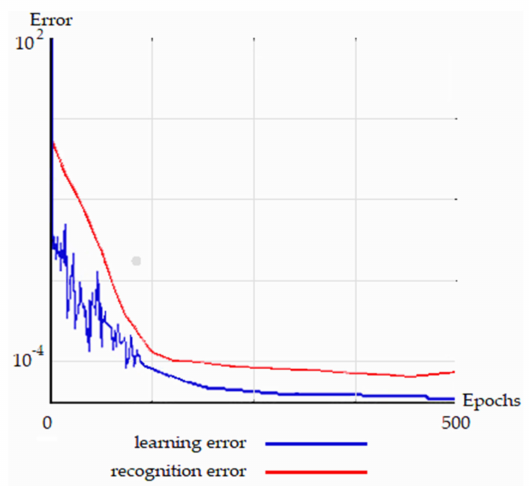
Figure 12. Graphs of changes in the dependence of the learning